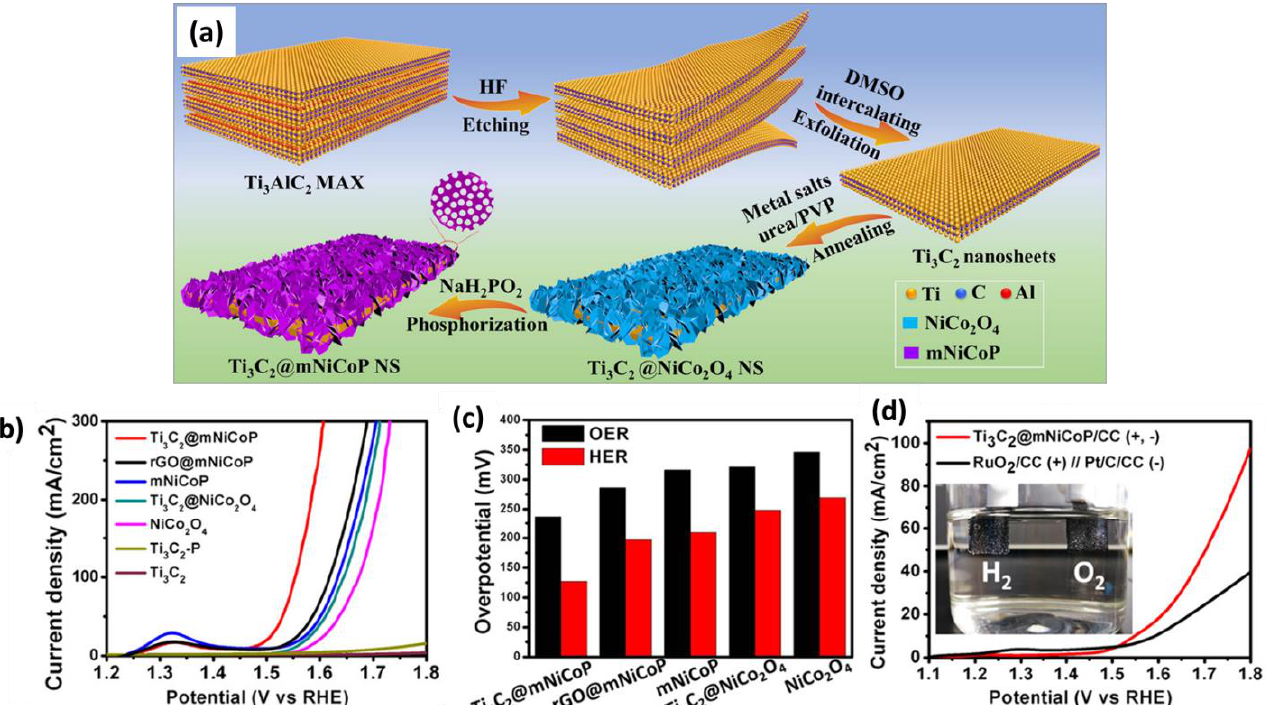
Figure 10. ( a ) Schematic illustration of the synthesis of hierarchical Ti 3 C 2 @mNiCoP NS and electrochemical test results, including a comparison of ( b ) polarization curves, ( c ) overpotentials, and (d) a photo of a water-splitting cell. Adapted with permission [70]. Copyright 2020, American Chemical Society.